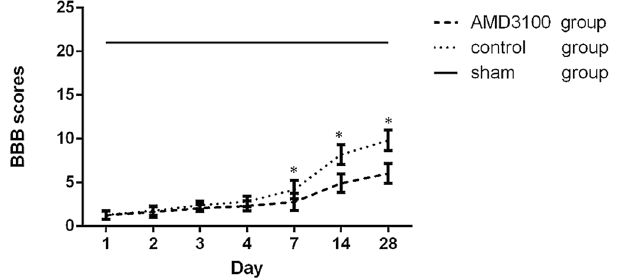
Figure 2. The BBB scores of the rats during the 28 days period after surgery in the three groups. It showed that the scores were significantly lower in AMD3100 group than those in untreated group on the 7th, 14th and 28th day after SCI. ( * P < 0.05).